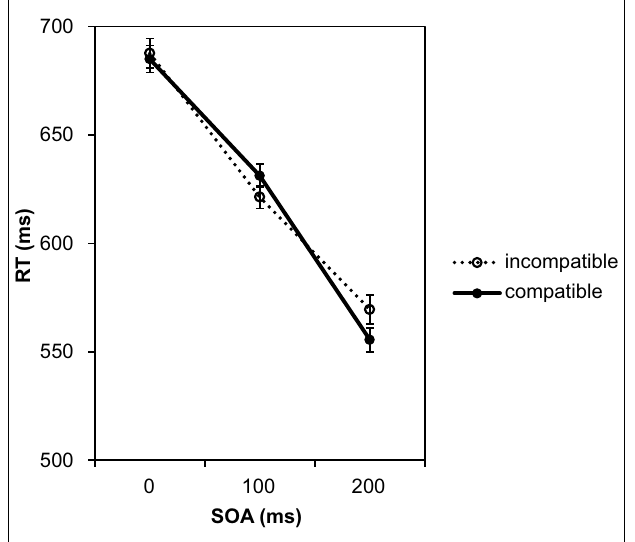
FIGURE 4 | Mean reaction times depending on SOA and compatibility conditions in Experiment 2. Compatibility is defined in relation to the response effects presented in the acquisition phase for each of the